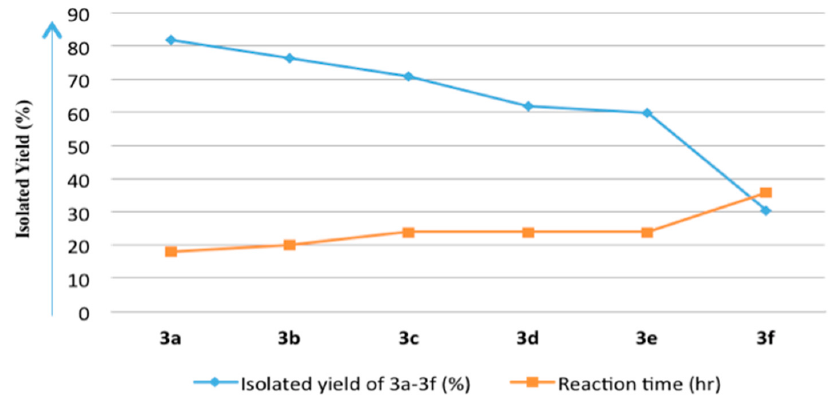
Figure 3. Conversion of 7,8-dihydroxy-4-methylcoumarin ( 1 ) to 8-acyloxy-7-hydroxy-4-methylcoumarins 3a – 3f using Rhizopus oryzae lipase (ROL).